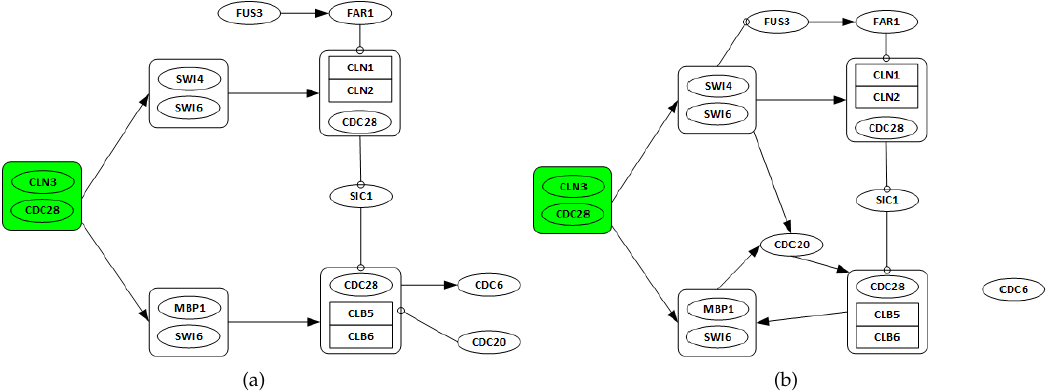
Figure 4. Known and recovered GRN for cell cycle pathway in yeast Saccharomyces cerevisiae . ( a ) target pathways of the 14 genes. CDC28 associates with cyclin CLN3 at the start of mitosis to cause the activation of SBF (SWI4/SWI6) and MBF (MBP1/SWI6), promoting the transcription of CLN1, CLN2. At G1 phase CDC28 associates with G1-cyclins CLN1 to CLN3, while B-type cyclins CLB1 to CLB6 regulate CDC28 during S, G2, and M phases. CLN1 and CLN2 interacting with CDC28 promote activation of B-type cyclin associated Cyclin-dependent kinase (CDK), which drives DNA replication and entry into mitosis. Adapted from [41]. ( b ) recovered yeast cell cycle pathway. The arrows show the direction of regulation. Some key regulations like activation (positive regulation) of the SBF (SWI4/SWI6) and MBF (MBP1/SWI6) complexes by the starter complex (CDC28/CLN3) are